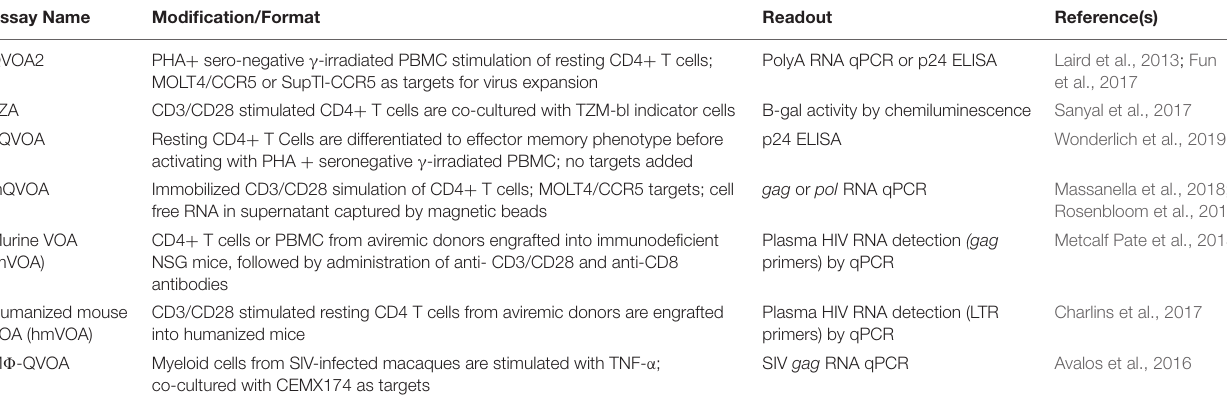
TABLE 2 | Overview of modified qVOA